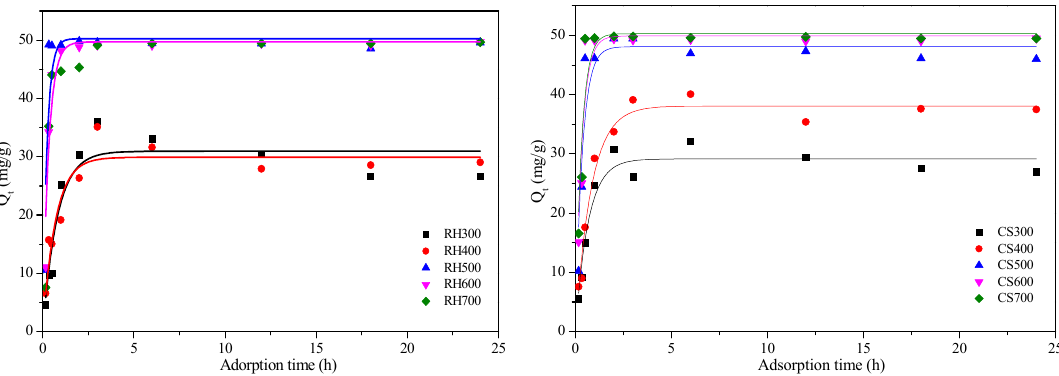
Figure 6. First-order kinetics analysis for Cd 2+ adsorption by both sets of biochar samples. Notes: RH300, RH400, RE500, RH600, and RH700 indicate that rice husk were pyrolyzed at 300, 400, 500, 600 and 700 °C, respectively; CS300, CS400, CS500, CS600, and CS700 indicate that cotton straw were pyrolyzed at 300, 400, 500, 600 and 700 °C, respectively.